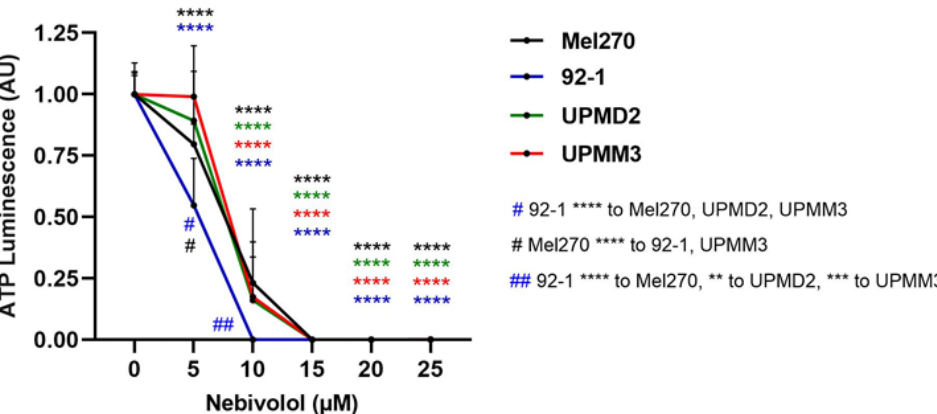
Figure 6. 2D cell culture viability assay following the treatment with nebivolol. UM cell cultures Mel270, 92-1, UPMD2, and UPMM3 were treated once with nebivolol at the indicated concentration for 7 days. A cell viability ATP luminescence assay was performed, and the ATP luminescence of the treated cells was normalized to the ATP luminescence of the control cells (0 µ M nebivolol), given in arbitrary units (AU). The means ± SD of three independent experiments for each UM cell line with n = 6–8 cultures each concentration are shown. Statistical analysis by two-way ANOVA and Tukey’s multiple comparisons test and the significance levels of the treated spheroids in relation to the control spheroids (0 µ M nebivolol) are highlighted in color. Significance levels are indicated at **** p < 0.0001. The significance level of nebivolol treated cell lines compared to other cell lines is indicated by # or ## (figure legend bottom right corner ** p < 0.01, *** p < 0.001, **** p < 0.0001) .